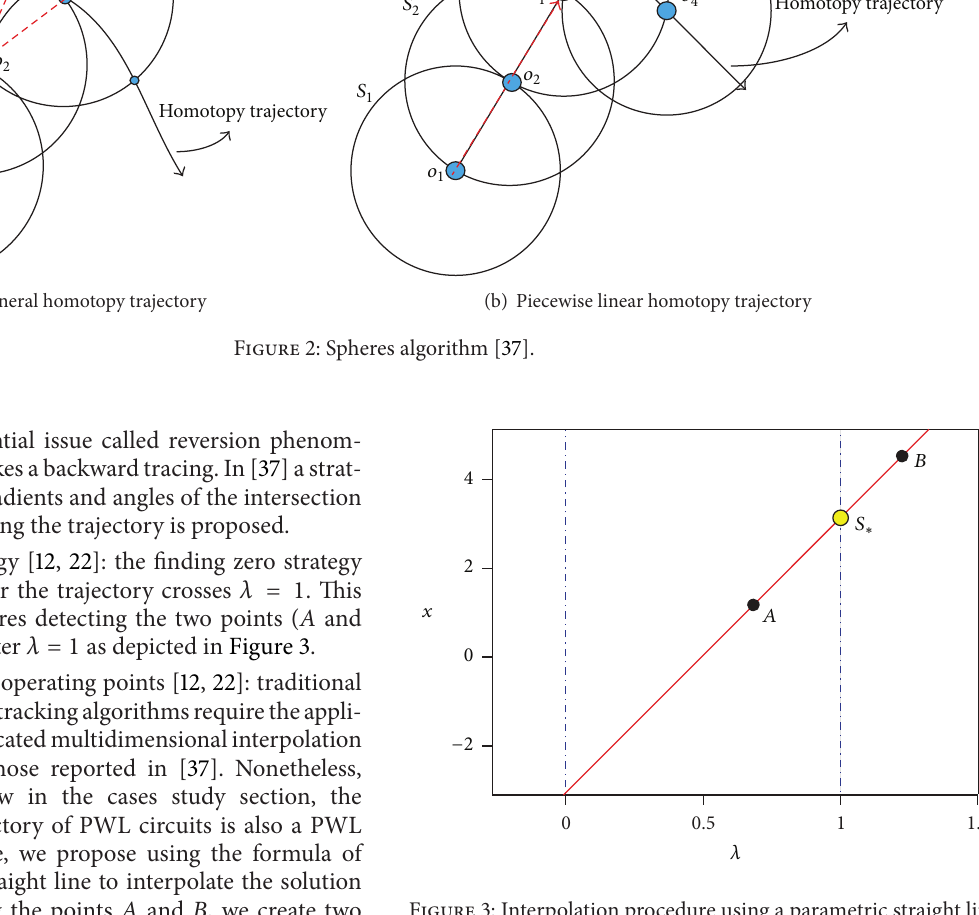
Figure 3: Interpolation procedure using a parametric straight